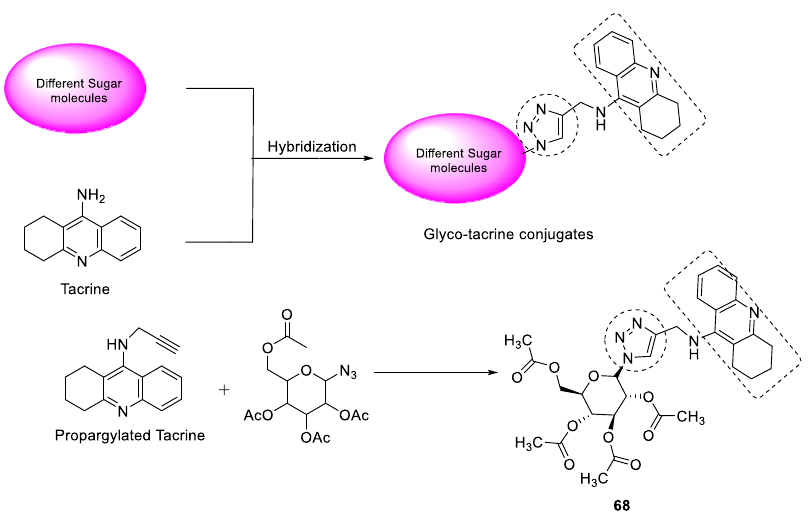
Figure 22. Chemical structure of tacrine – 1,2,3-triazole